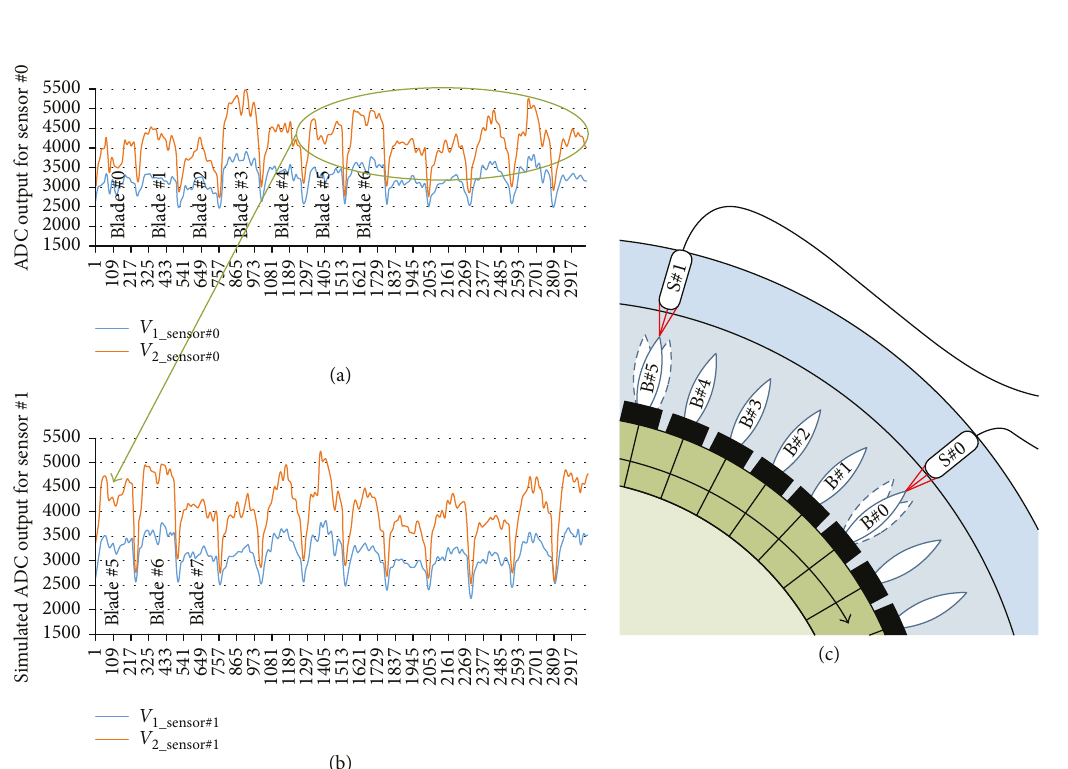
V Figure 6: V 1 and 2 waveforms for two sensors: (a) master sensor (S#0) at blade #0; (b) slave sensor (S#1) facing blade #5; (c) two-sensor simulation